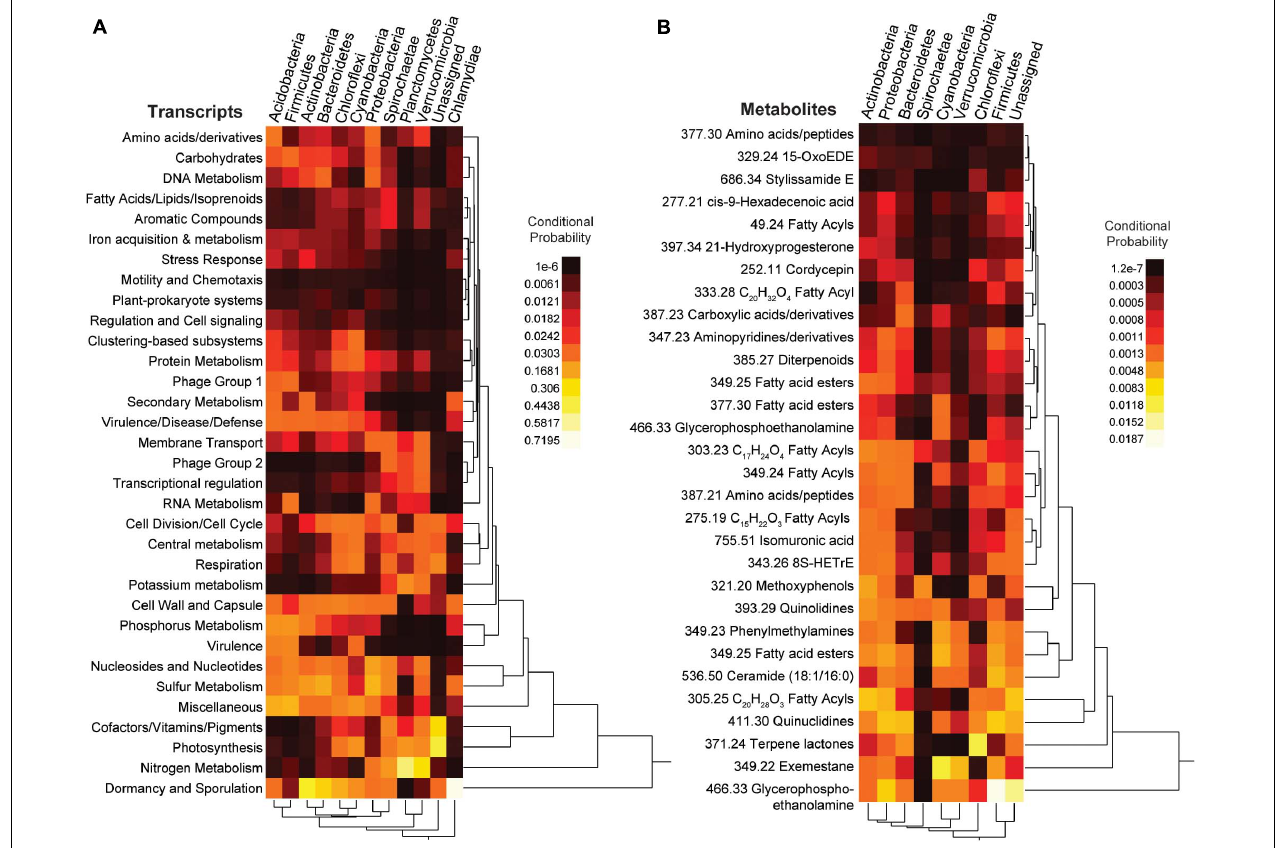
FIGURE 9 | Heatmaps from the neural network (mmvec) analysis. The conditional probability (dark red/black for low and yellow/white for high) that the presence of a transcript or metabolite corresponds to the presence of a specific bacterial phylum is shown. (A) Top SEED Level 1 transcript predictors from supervised random forest analysis; (B) Top known metabolite predictors from supervised random forest analysis. For metabolites the number in front of the annotation is the mass to charge